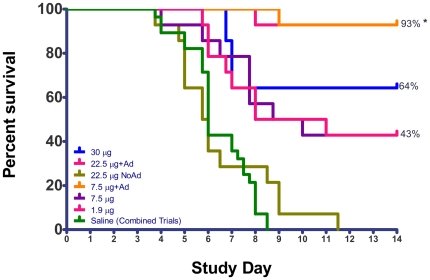
Survival proportions demonstrate adjuvant advantage.Saline vaccinated, control animals, from both vaccine trials are combined. Asterisks (*) denotes a significant difference between survival rates of 93% (adjuvanted vaccine) and all others (Log-Rank test, p<0.001).